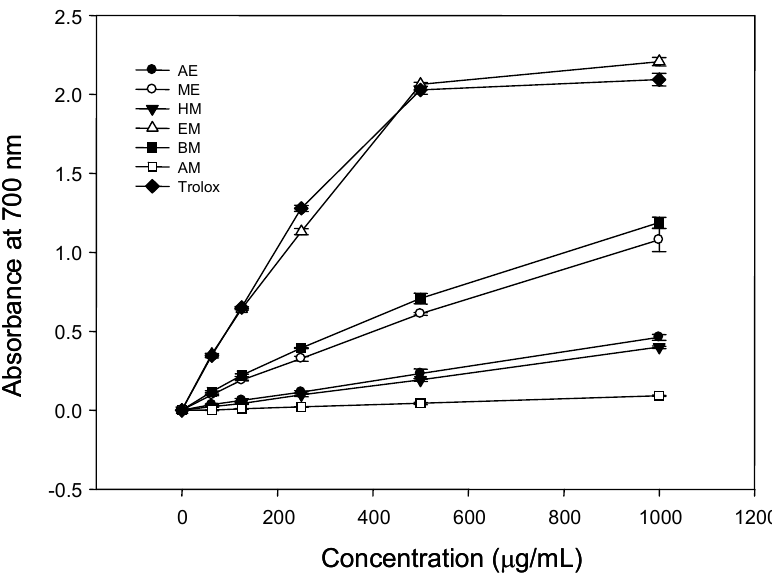
Figure 5. Reducing powers of different Bidens pilosa flower extracts. Trolox was used as positive control. Each bar represents the means ± SD of triplicate experiments. AE: aqueous extract, ME: methanol extract, HM: n -hexane fraction, EM: ethyl acetate fraction, BM: n -butanol fraction, AM: the remaining aqueous